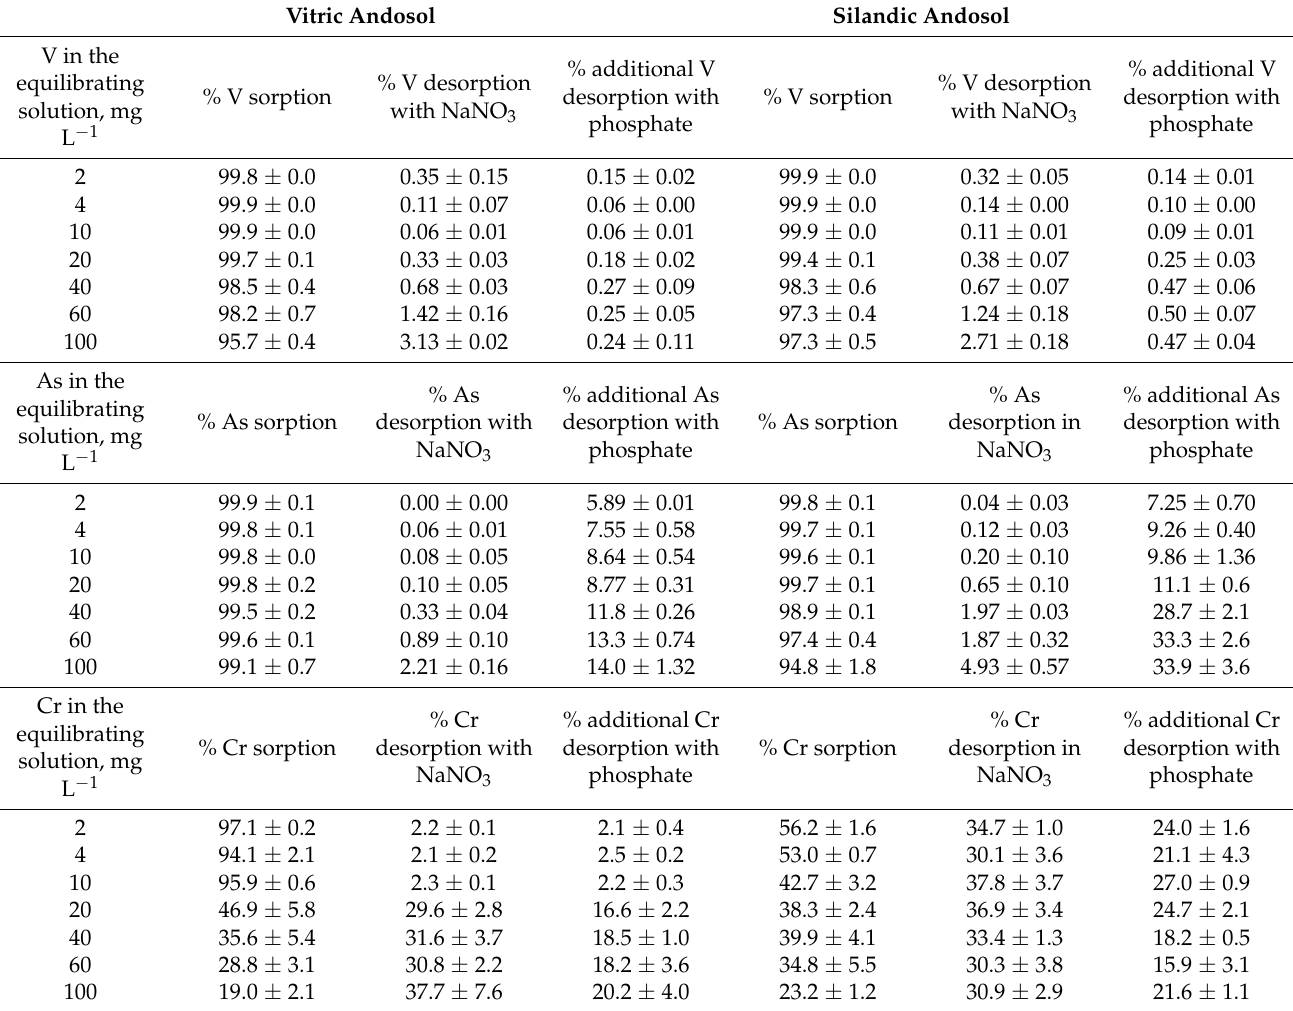
Table 2. Percent sorption and desorption of oxyanions in the studied soils. Vitric Andosol Silandic